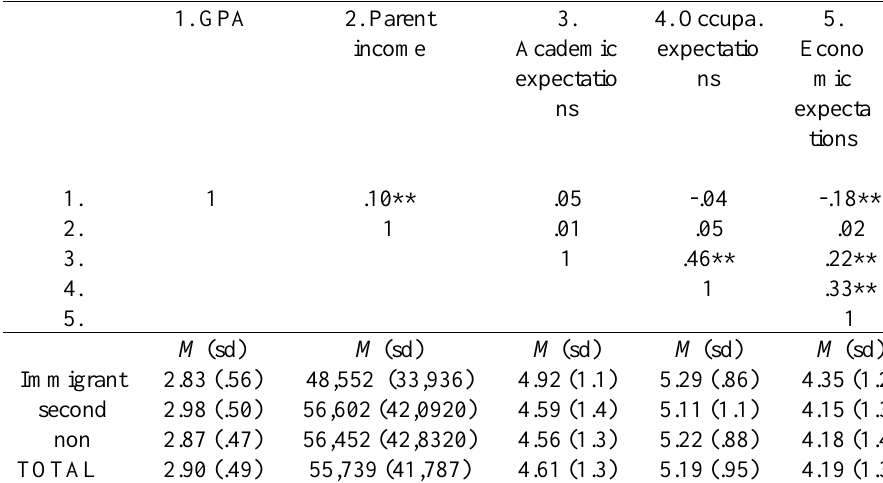
Sample means and